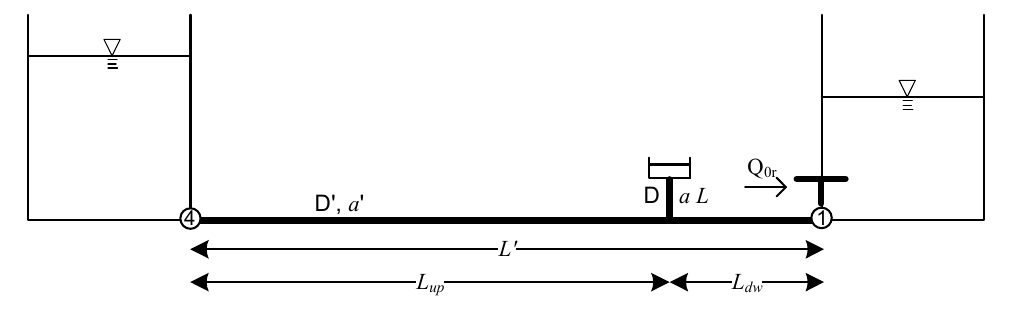
Figure 1. RPSPV system schematic.